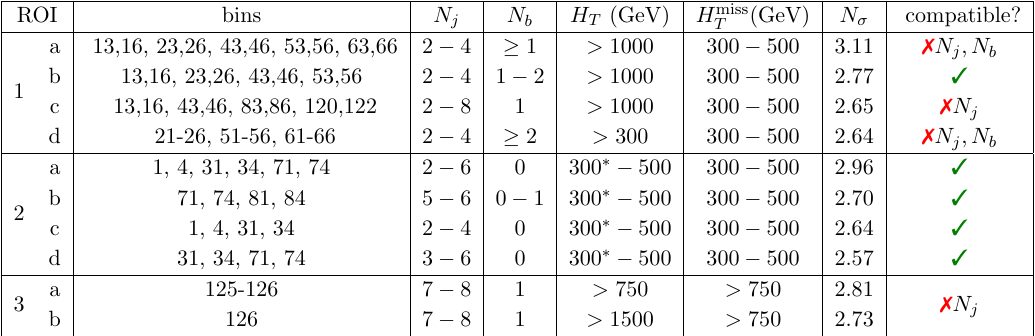
Table 2 . The aggregated regions in CMS033 [13] with the highest local discrepancy between the data and the background. The asterisks in the H T column mark requirements that do not apply to all the aggregated bins, that is, H T > 350 GeV for SRs 4, 34, 74, 84. We mark the compatibility of each excess by 3 (if compatible), 7 (if not compatible with nearby SRs in the same search)